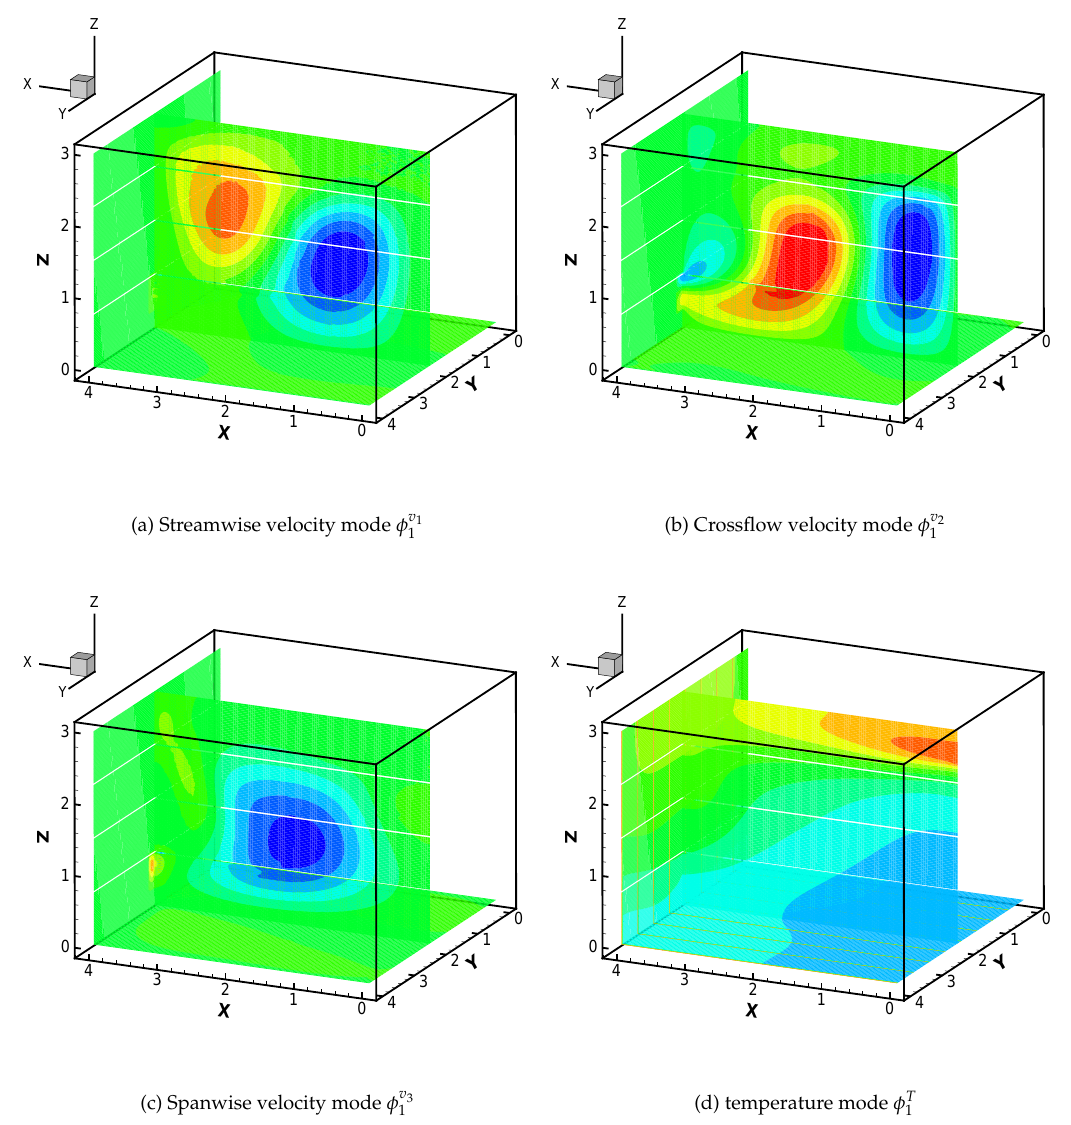
Figure 6. The first velocity and temperature POD modes.